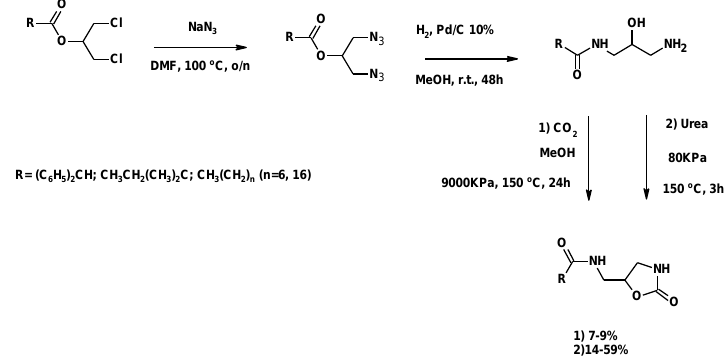
Figure 23. Synthesis of oxazolidinones from dicholoralcohol esters.